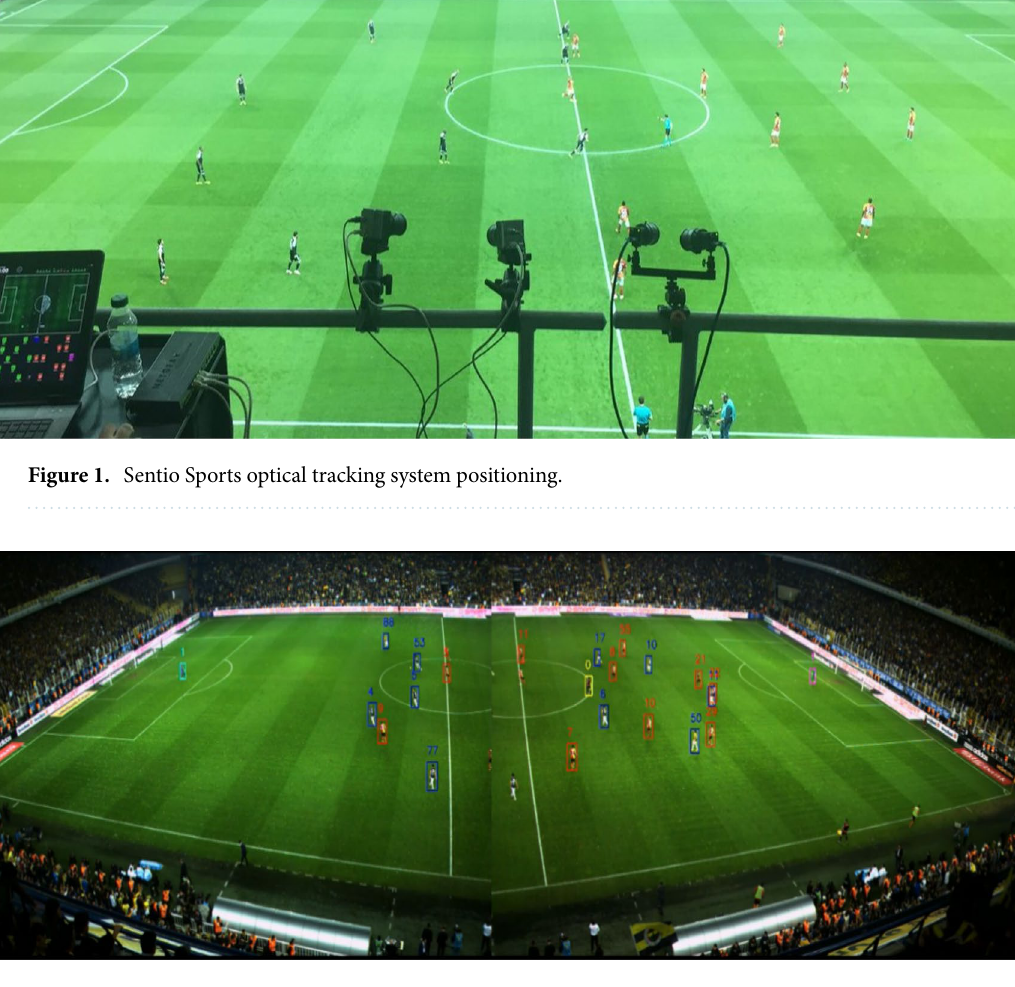
Figure 2. Full field view of cameras belongs to Sentio Sports optical tracking